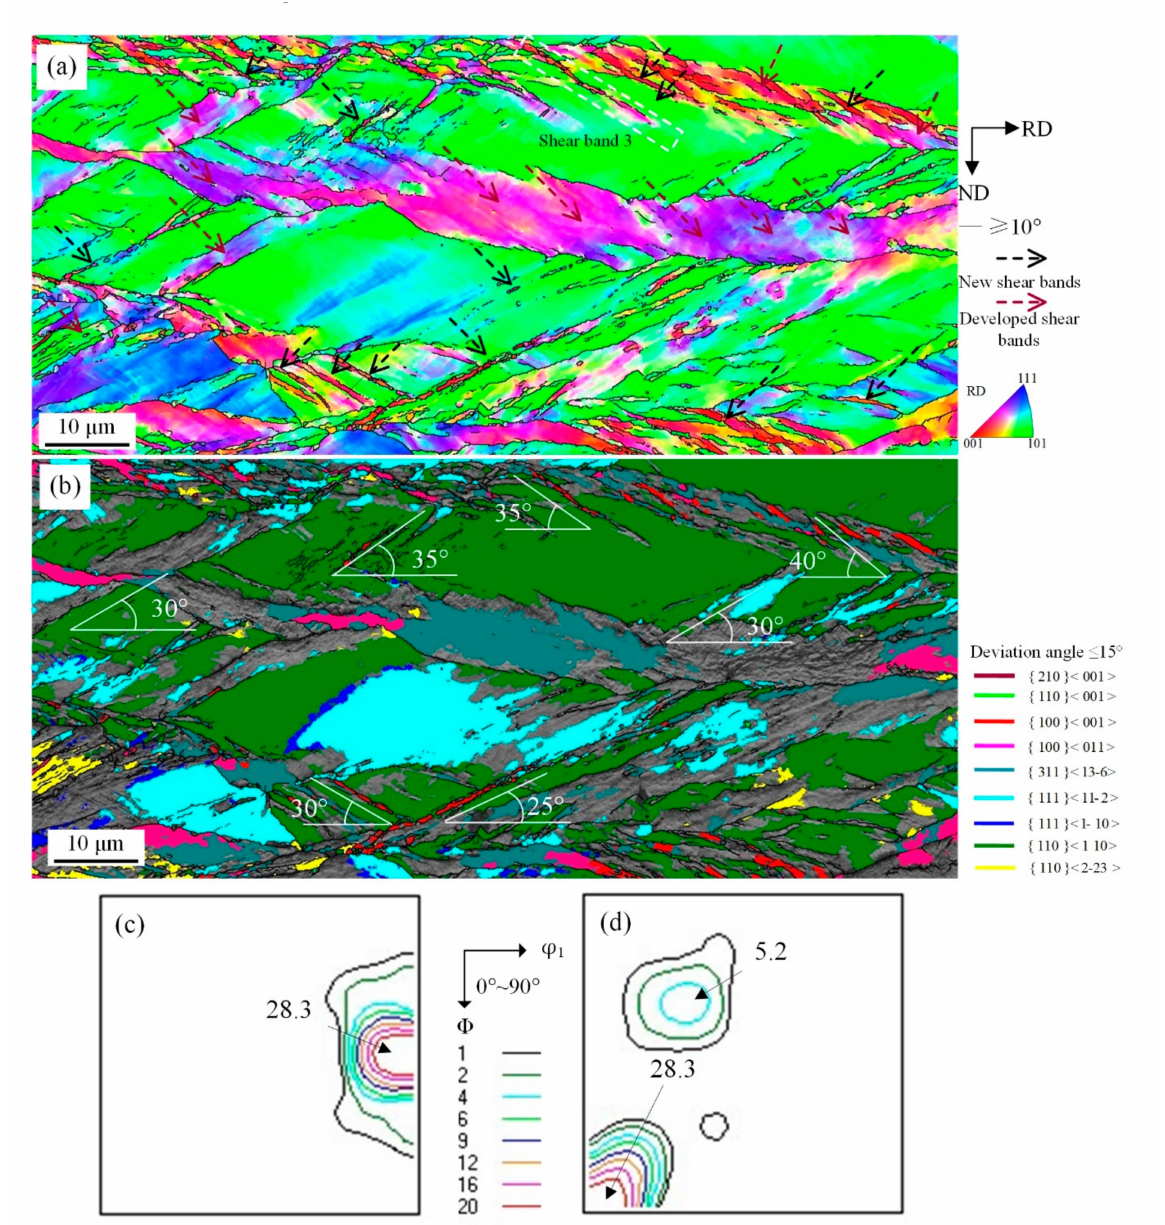
Figure 5. EBSD orientation maps of shear bands with {110}<110> under 67% reduction ( a ) ESBD inverse pole figure of cold-rolled sheet; ( b ) several texture components colored in orientation maps of cold-rolled sheet (deviation angle ≤ 15 ◦ ); ( c ) ODF of EBSD data presented at ϕ 2 = 0 ◦ section; ( d ) ODF of EBSD data presented at ϕ 2 = 45 ◦